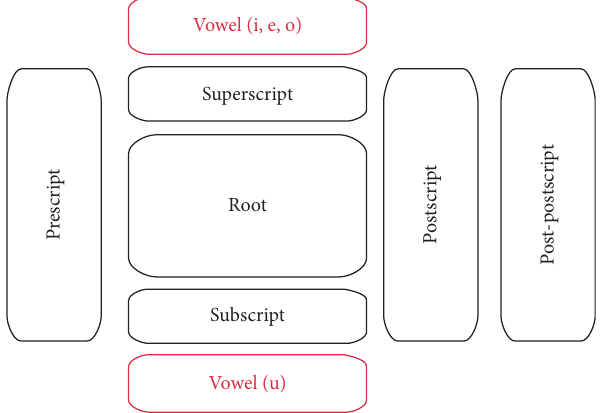
Figure 3: The structure of a Tibetan